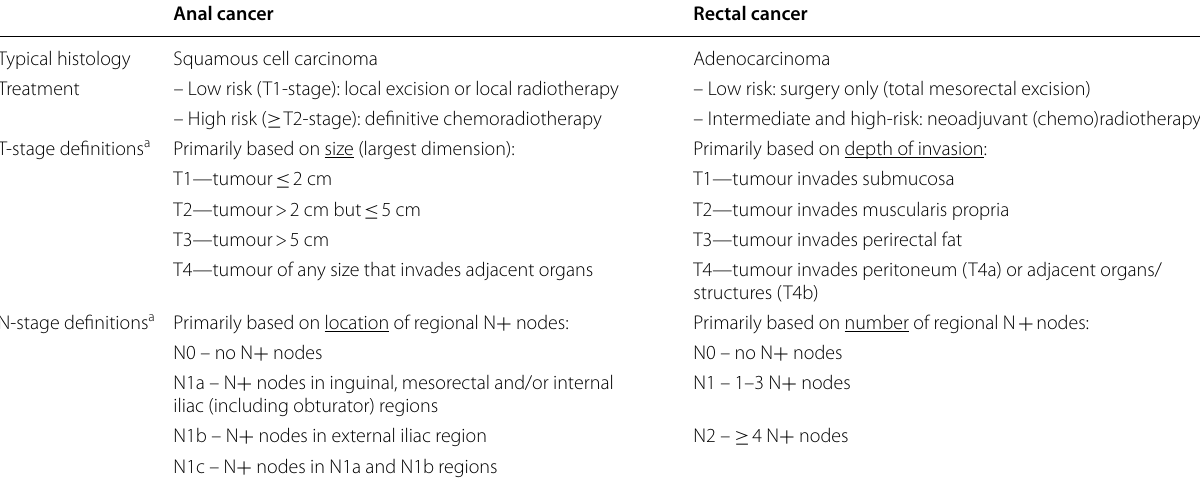
Table 2 Main differences in staging and treatment stratification between anal and rectal